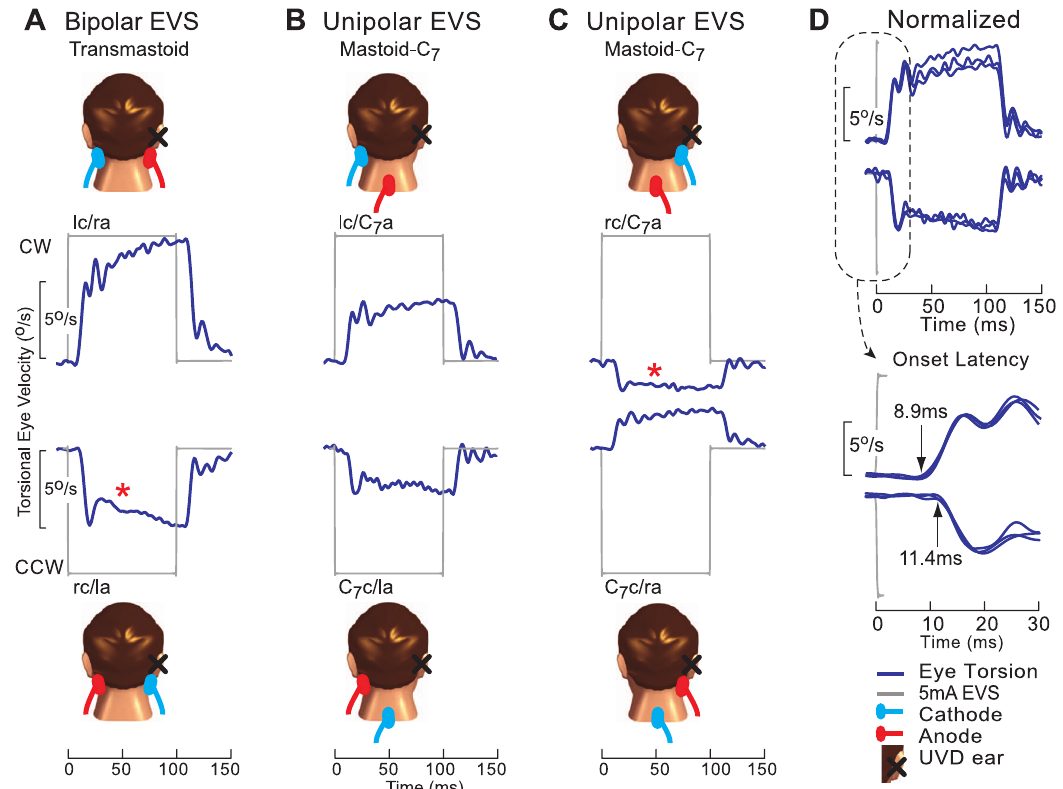
Figure 4. Effect of current spread in human unipolar EVS of UVD patients. The eVOR to unipolar 5.0 mA cathodal and anodal EVS in grouped right UVD with functioning left ear illustrated by a typical patient. (A) The eVORs from left-cathode/right-anode (lc/ra) and to right-cathode/ left-anode (rc/la) bipolar EVS were largest. (B) When left-cathode/C 7 -anode (lc/C 7 a) and C 7 -cathode/left-anode (C 7 c/la) unipolar EVS stimulated the functioning left ear, the eVOR was about half the bipolar eVOR. (C) However when right-cathode/C 7 -anode (rc/C 7 a) and C 7 -cathode/right-anode (C 7 c/ ra) unipolar EVS stimulated the right UVD ear, instead of the expected absent response, it was one-third the bipolar eVOR. The polarity of the eVOR was consistent with the C 7 - electrode polarity suggesting that current may have spread from the C 7 -electrode closer to functioning left ear. (D) When the eVOR from all three configurations were grouped according to direction of their responses (i.e. CW or CCW) and then normalized, they share similar spatio-temporal characteristics with the mean excitatory eVOR latency of 8.9 ms and inhibitory latency of 11.4 ms suggesting that the eVORs were generated from the functioning left ear. (Schemes show electrode locations on the patient).